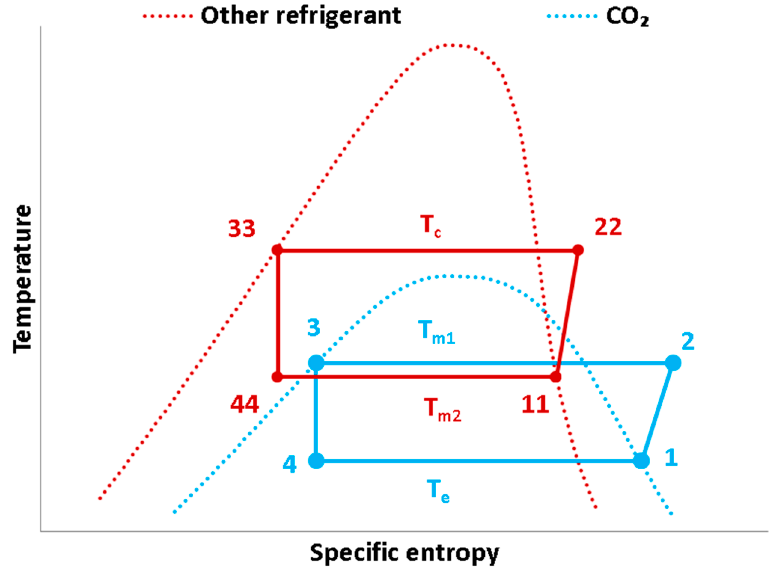
Figure 2. Typical temperature-specific entropy figure for the examined processes.